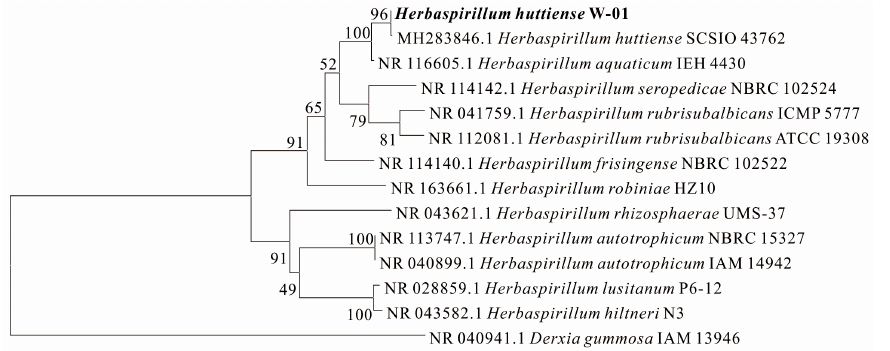
1500 Figure 1. Phylogenetic tree of the strain based on 16S rRNA sequences (the length of the sequence is 1500 bp).